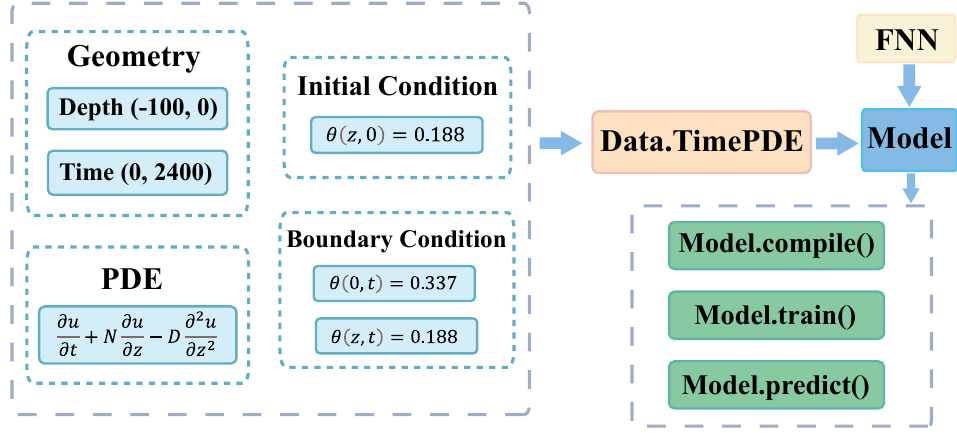
Figure 8. The principle for the solution of the equations using